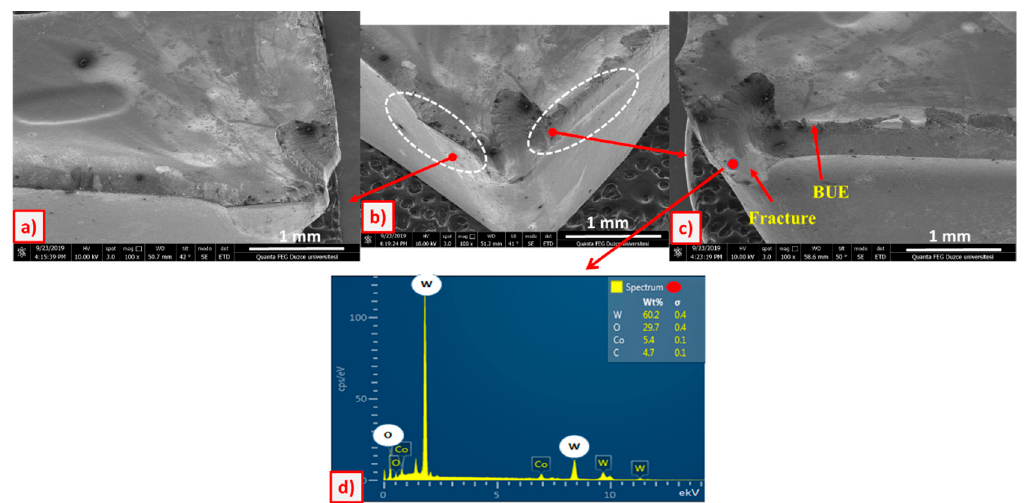
Figure 11. SEM images ( a – c ) and EDX analysis values ( d ) of tool wear that occur on cutting tools as a result of the milling of NiTi SMA with 0.4 mm r ε under different machining parameters.